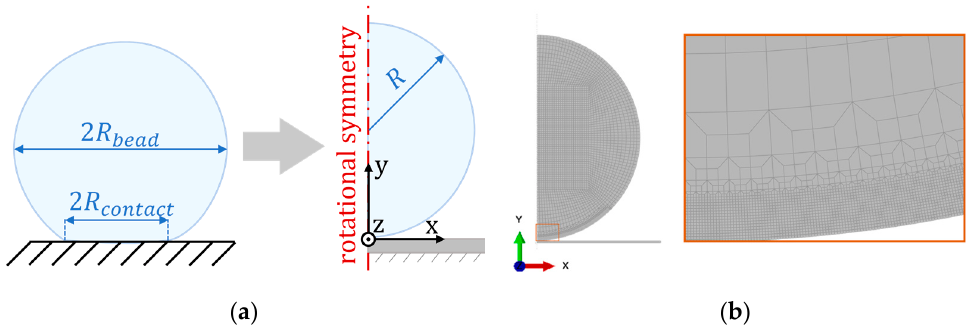
Figure 1. Model symmetries ( a ) and final FE-model with mesh used, including a close-up of transition elements ( b ).